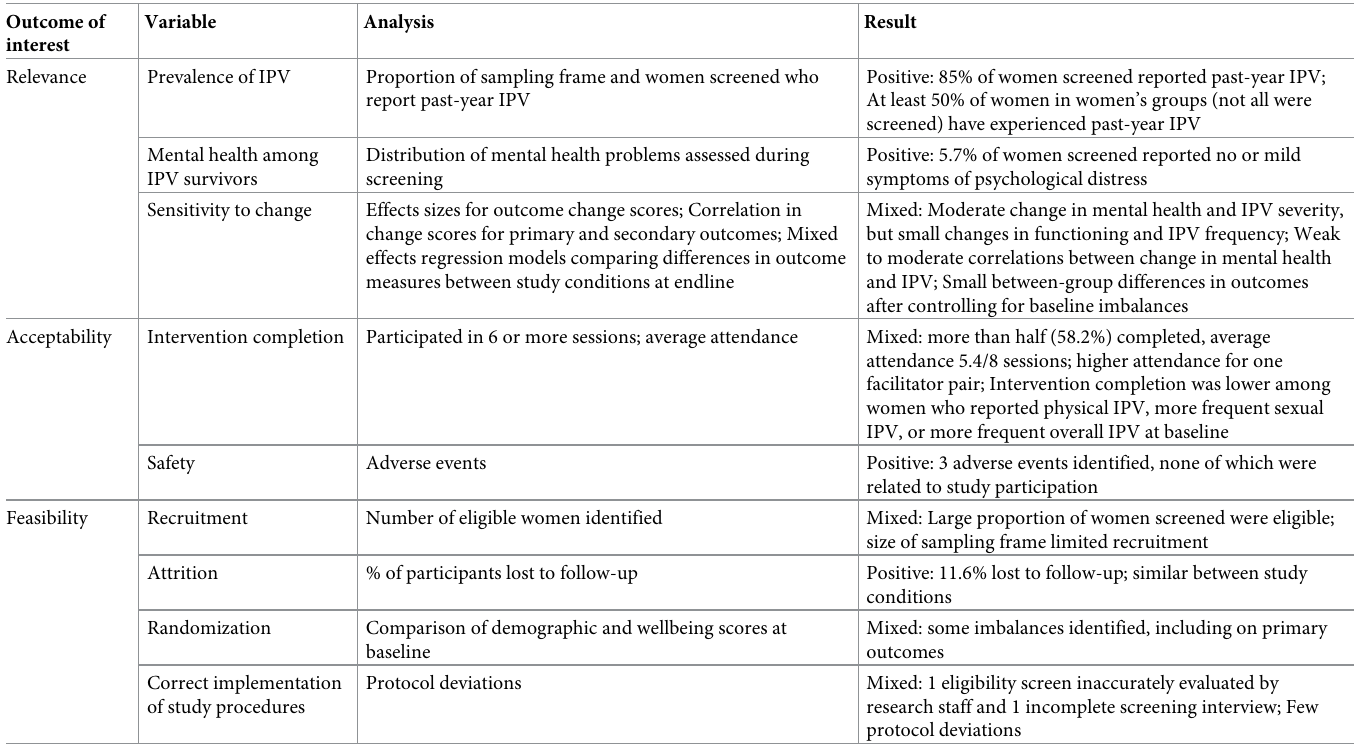
Table 2. Summary of